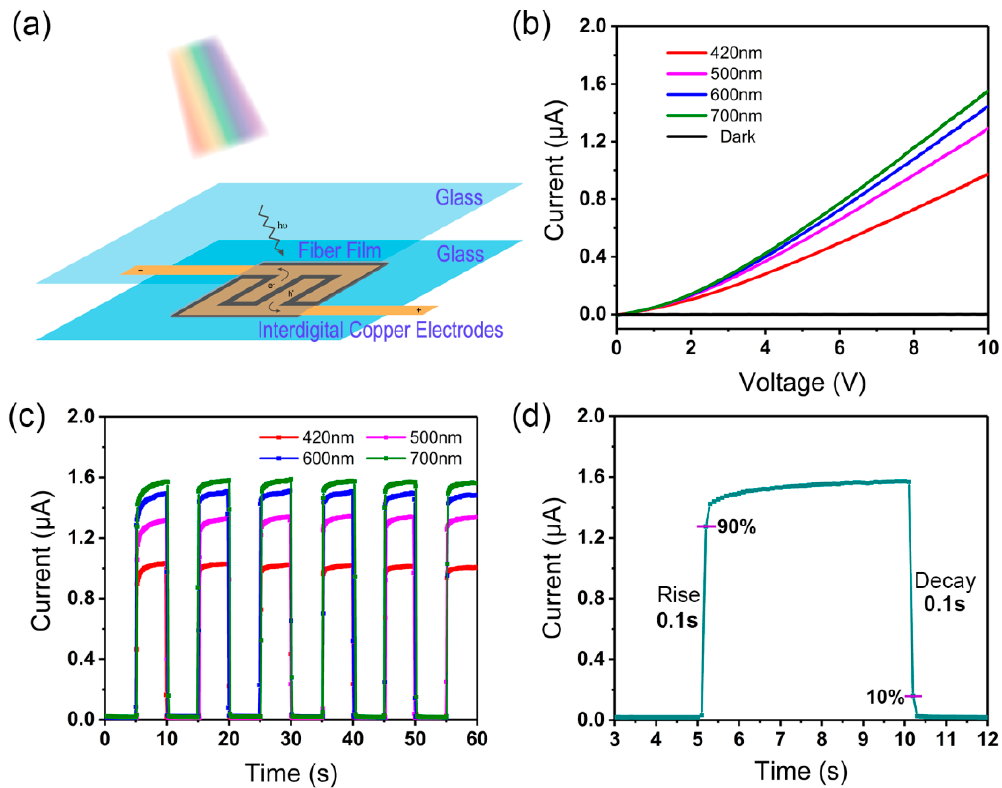
Figure 6. Photoresponse performance of the photodetectors. ( a ) Schematic illustration of the photodetector. ( b ) Current-voltage curve and ( c ) photocurrent responses of the detector based on the M85.7 fibers. ( d ) Transient response of the photodetector based on the M85.7 fibers.